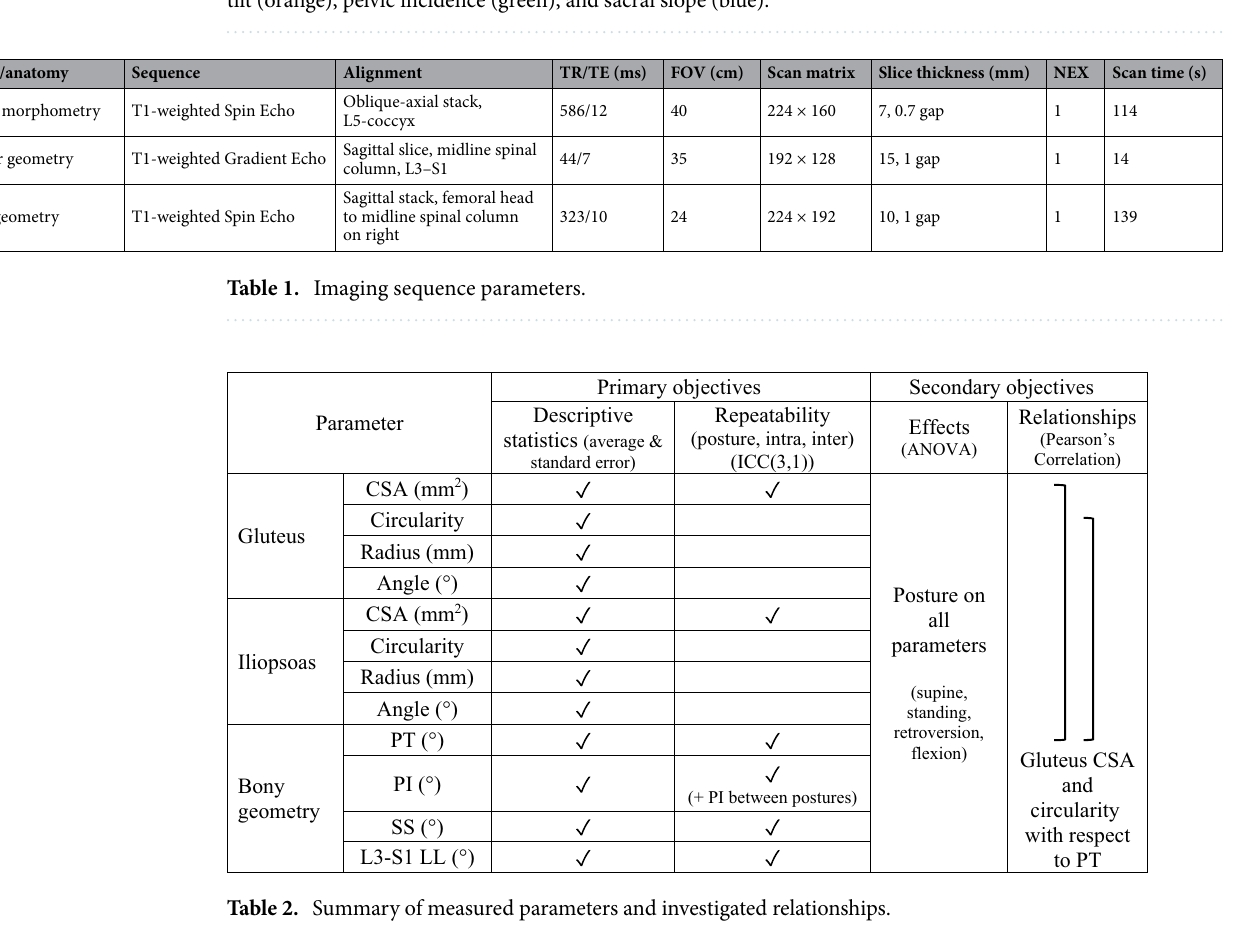
Figure 1. Diagram of postures, image slice orientation, and image analysis measurements. ( a ) Standing posture, ( b ) Standing with pelvic retroversion (retroversion) posture, ( c ) Standing with 30° flexion from the hip (flexion) posture. ( d ) For muscle morphometry, an oblique image stack was aligned to the sacral endplate and covered midpoint of L5 to the coccyx. ( e ) Muscle cross-sectional area (CSA) boundaries were outlined for the gluteus (yellow) and iliopsoas (red), with the intervertebral disc also outlined (blue). Circularity and centroid of the CSA were automatically determined in Image J. ( f ) Position measurements of radius (mm) (dark green) as distance between centroid of the muscle to centroid of the intervertebral disc, and angle (degrees) (blue) measured relative to the line running posteriorly from the intervertebral disc centroid to the spinous process. ( g ) For pelvic geometry, a sagittal scan was aligned to the midline of the spinal column covering L3 to S1 (orange), and a sagittal stack covered the femoral head and midline of the spinal column on the right (red). ( h ) Measurement of L3–S1 lumbar lordosis (purple) as the angle between the L3–S1 superior endplates. ( i ) Measurements of pelvic tilt (orange), pelvic incidence (green), and sacral slope (blue).